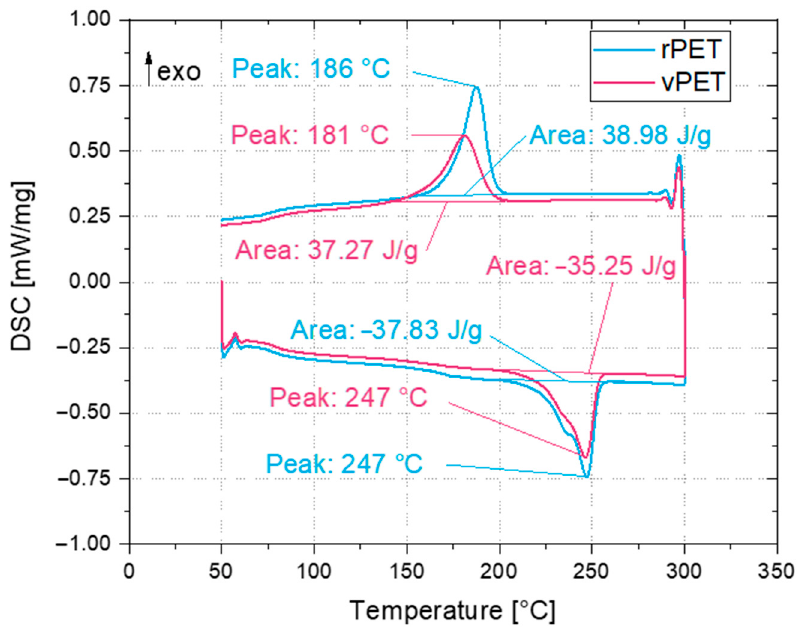
Table 6. Results of the second heating cycle of the DSC.